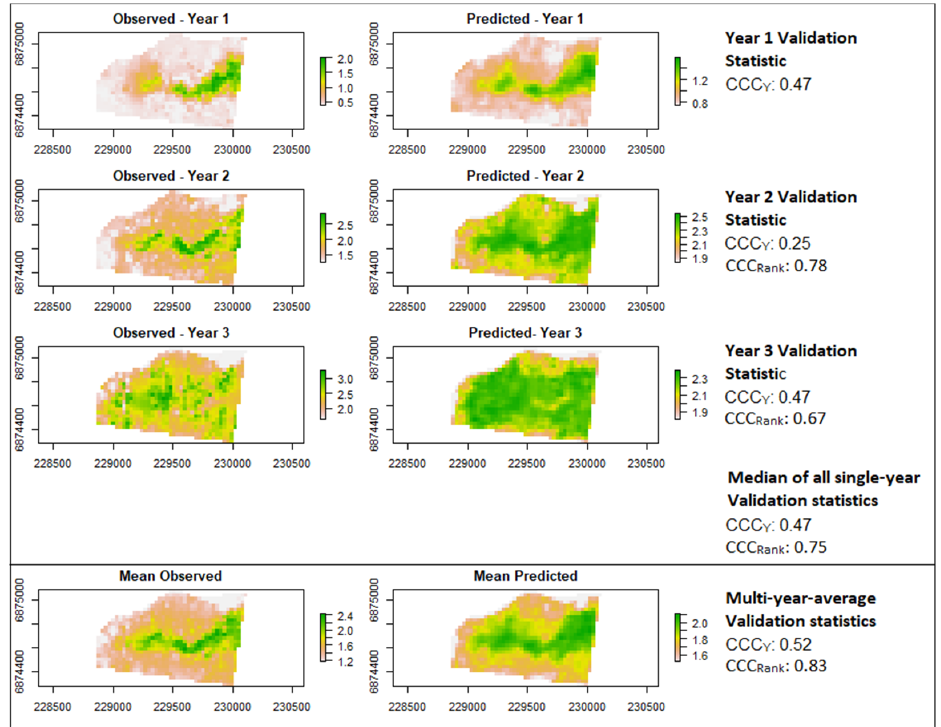
Figure 6. Single and multi-year yield maps of Field 23. The horizontal and vertical axis of the map